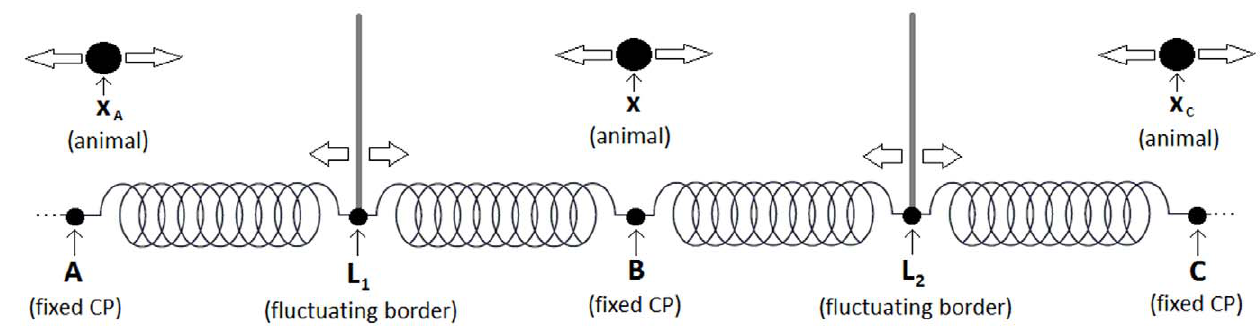
Figure 2. Diagram of the reduced analytic 1D model of territorial dynamics. The CPs are fixed at positions A , B and C (left to right). The territory borders are intrinsically subdiffusive and have positions L 1 and L 2 . Each animal moves diffusively with a constant drift towards the CP and constrained to move between the two territory borders to its immediate right and left. The position of the animal studied in the main text is denoted by x . The animals at x A and x C are drawn purely for illustrative purposes. In the Results section, B is assumed to be at 0 and B { A ~ C { B ~ L .